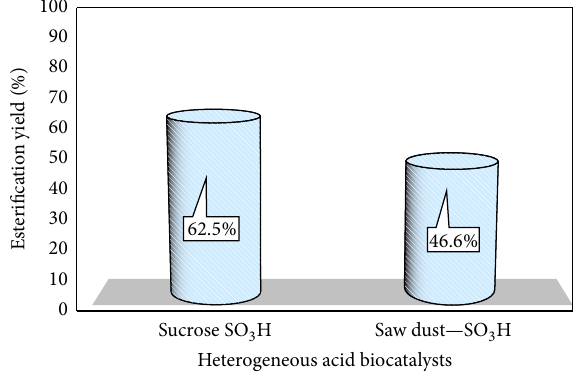
Figure 6: Esterification using heterogeneous acid biocatalysts. Experiment conditions: methanol/oil ratio 6: 1, temperature 70 ∘ C, time 180 minutes, and catalyst load 1%